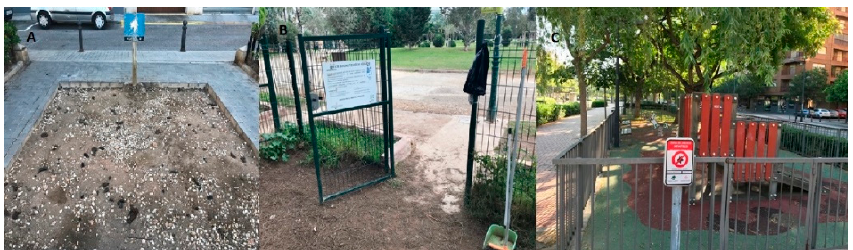
Figure 2. Types of studied areas. ( A ): canine sanitary area, ( B ): socialization area, ( C ): children’s playground.